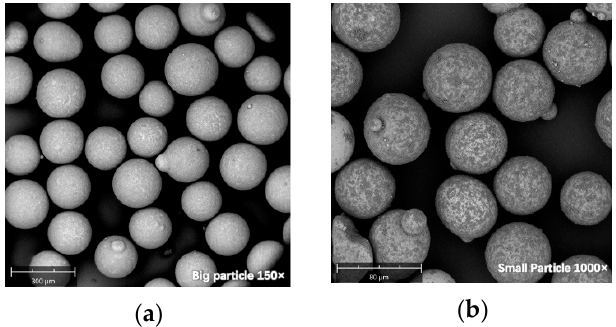
Figure A1. SEM images from experiments using ( a ) large particles; ( b ) small particles.